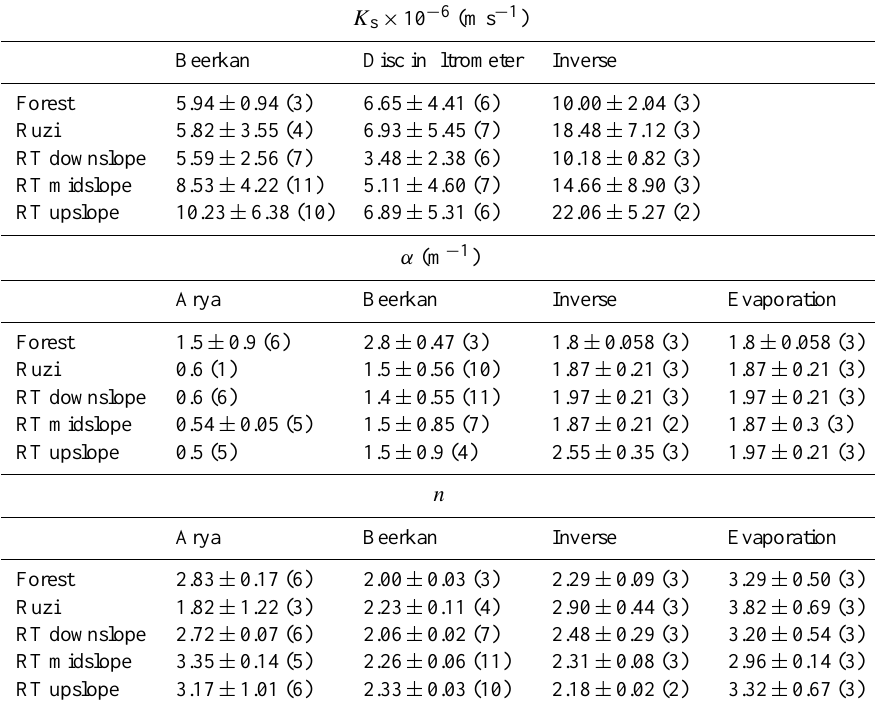
Table 3. Means and standard errors for the main van Genuchten parameters with Mualem conditions ( n = 1/ { 1 − m } ) determined for the different methods at the different sites. The number of samples is indicated in